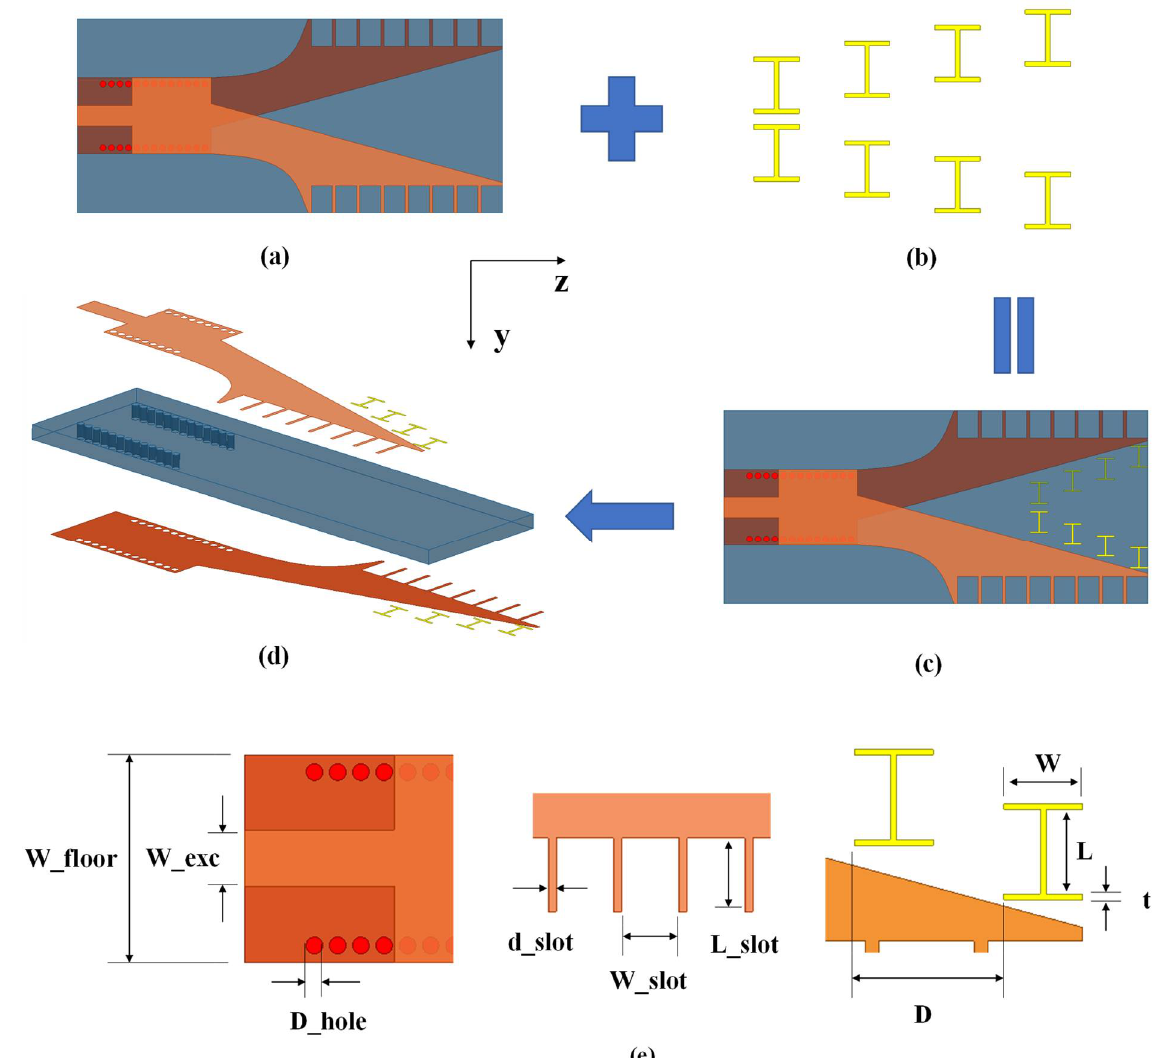
Figure 1. Configurations of the proposed wide-beam antenna. ( a ) Basic ALTSA. ( b ) Subwavelength units. ( c ) Proposed wide - beam antenna. ( d ) Exploded view. ( e ) Local geometries.